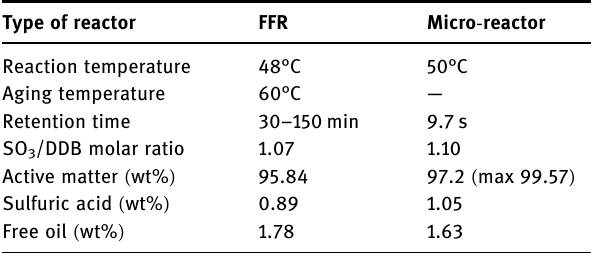
Table 4: Comparison of sulfonation process conditions and